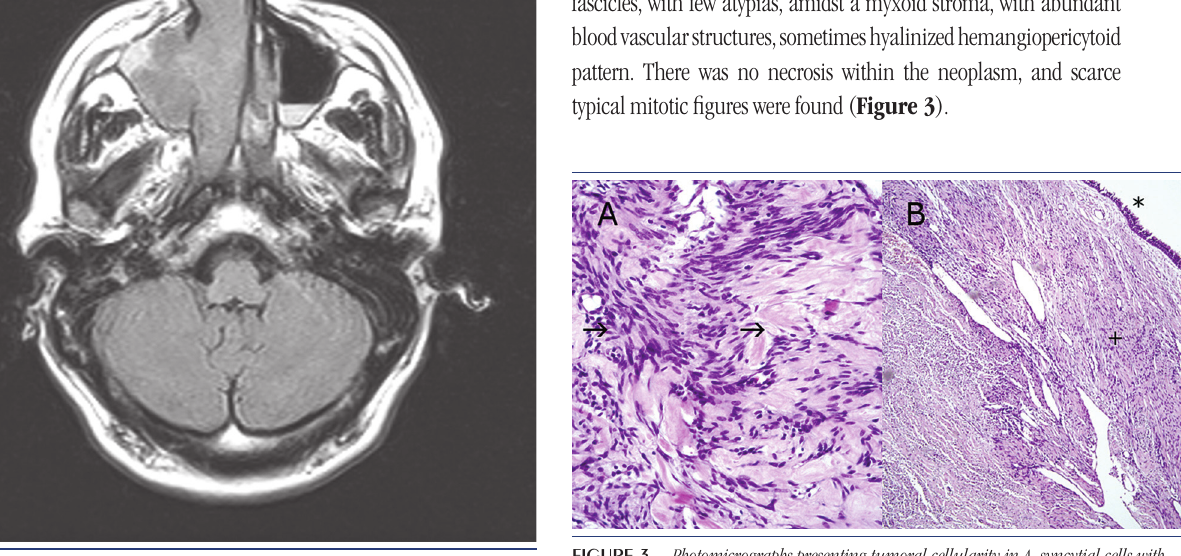
figurE 1 − MRI of axial section in FLAIR sequence, in which an expansive mass is visible, occupying the nasal cavity and the maxillary sinus on the right, with enlargement of drainage ostium MRI: magnetic resonance imaging; FLAIR: fluid-attenuated inversion recovery.